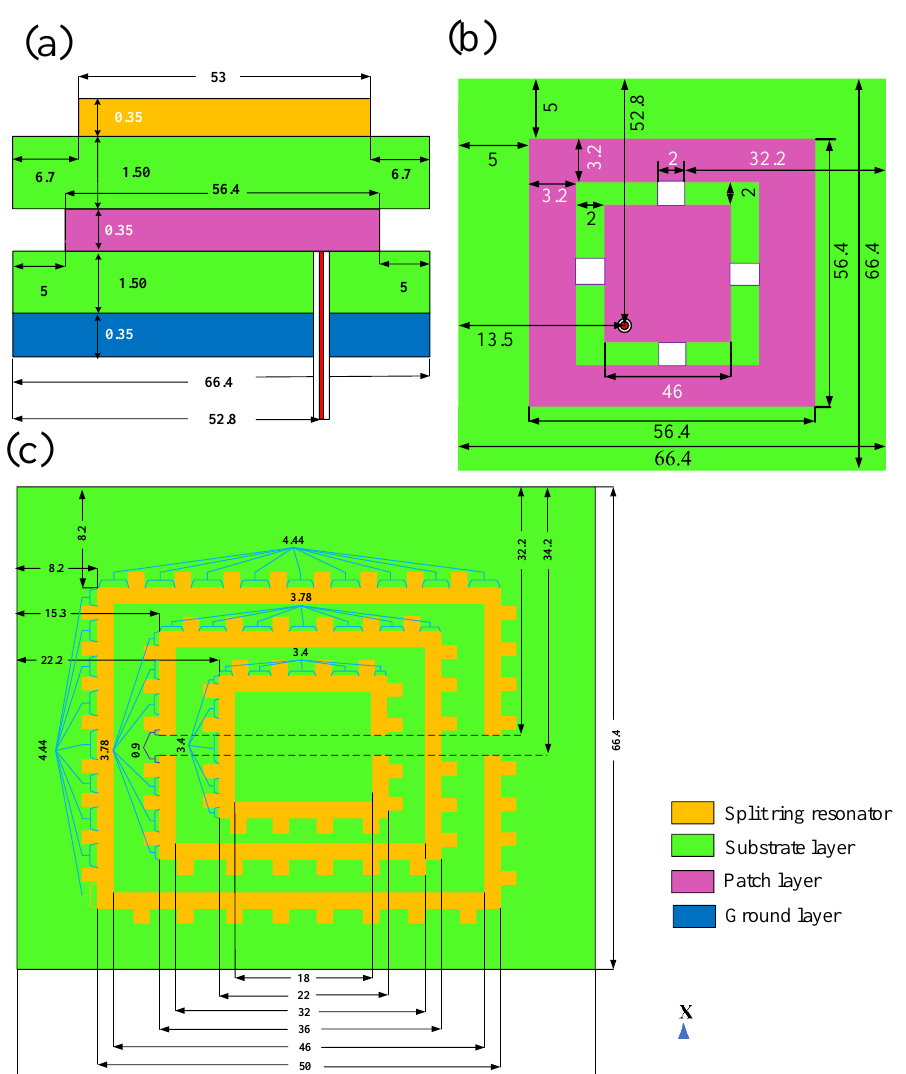
Figure 3. ( a ) Side view of a presented structure. ( b ) Top view of the patch. ( c ) Top view of the rectangular shaped MPA loaded with the tooth and SRR. Dimensions represented in the figure are in mm. In a SRR, the inductance effect is induced by the circular shape and the capacitance by the space is between two ring terminals. The inductance ( 𝐿𝑠 ) and capacitance ( 𝐶 𝑠 ) per unit length can be calculated by Equations (1) and (2) [48].